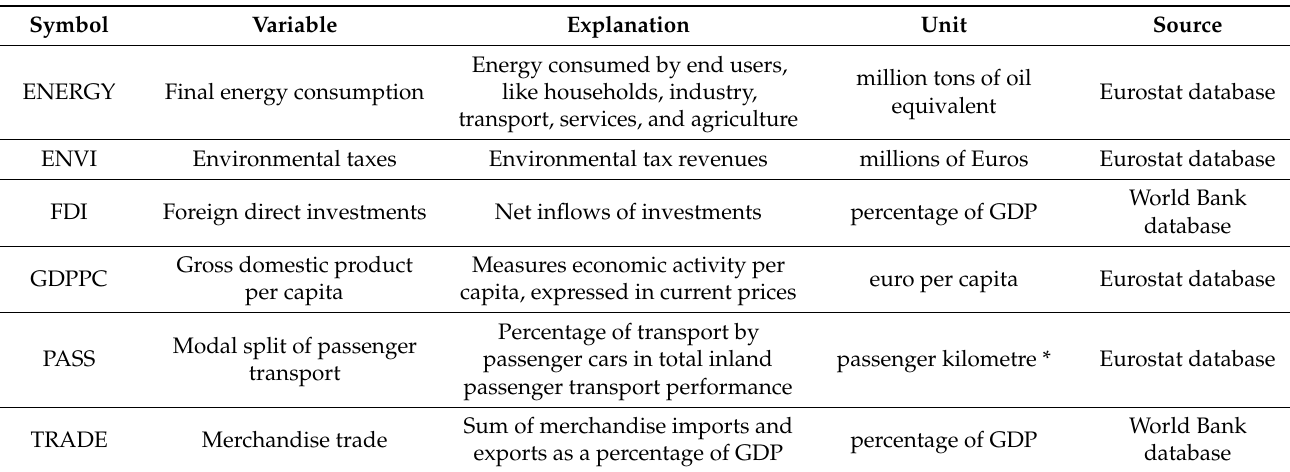
Table 2. List of independent variables. Source: